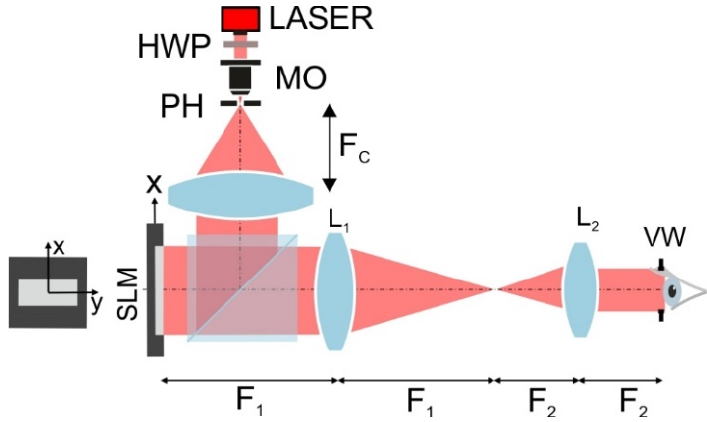
Figure 8. Scheme of wide-angle holographic display used for CGH optical reconstruction. Figure 9 shows optical reconstructions of CGH generated and reconstructed for four view angles: 0 ◦ , 45 ◦ , 180 ◦ and 275 ◦ . To fit the viewing angle of the display system, gargoyle dimensions are resized to 559 × 527 × 279 [mm 3 ]. Since the dimension of the cloud is reduced, the average angular spacing of the point cloud decreases to 0.030 ◦ . For this value, the N S must be smaller than 1900 pixels. Hence, former PAS parameters fulfill accuracy and speed for CGH calculation as well. Obtained results prove that the occlusion culling based-PAS can eliminate unwanted back points for each angle. Video S2 presents the optical reconstruction of the gargoyle from 0 ◦ to 360 ◦ . Here, the cloud of points was rotated 1 ◦ per